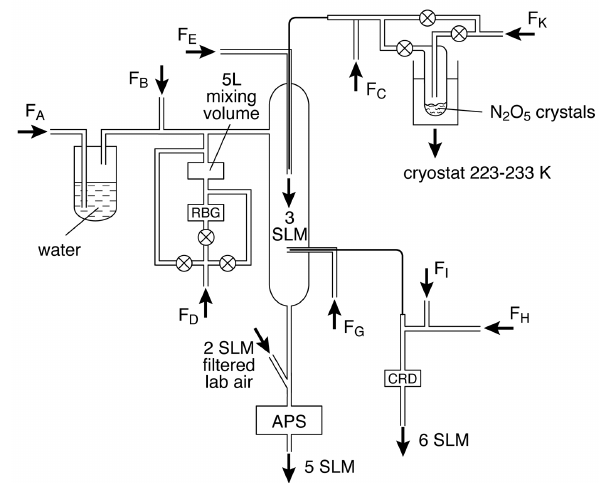
Fig. 1. Schematic diagram of the aerosol flow tube. RBG = rotating brush generator, APS = Aerodynamic Particle Sizer, CRD = cavity ring-down